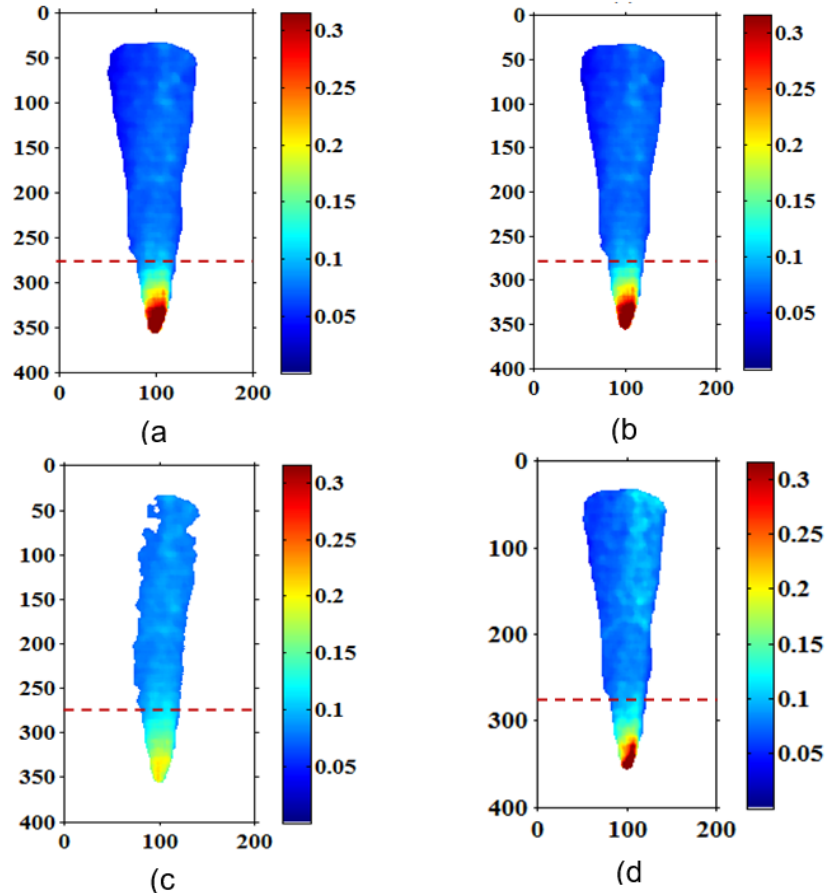
Figure 3. Comparison of image velocity field estimated using ( a ) WOV, ( b ) OPV, ( c ) NCC, and ( d ) FFT based velocimetries.